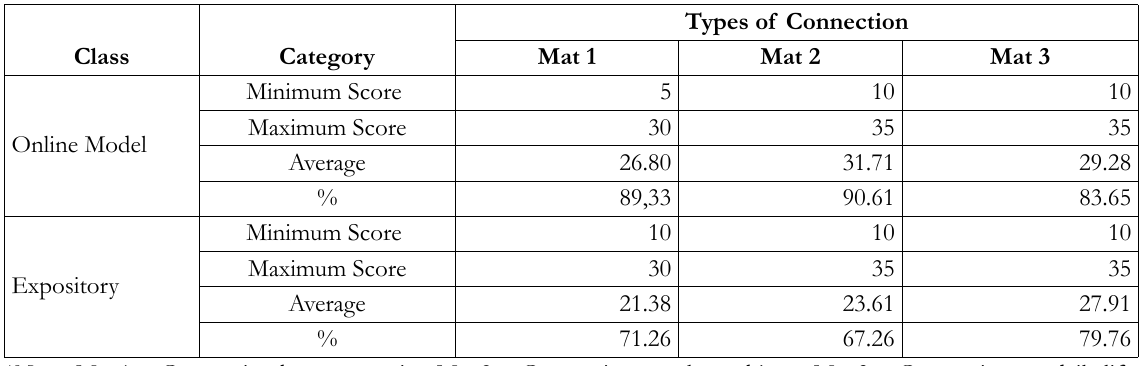
Table 2. Mathematic connection skill of the Students from the Type of Connections Category